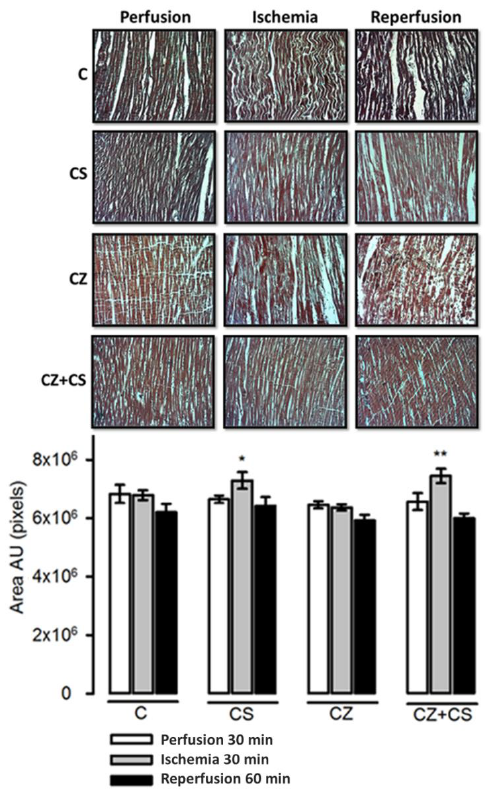
Figure 8. Representative photomicrographs of heart tissue after perfusion (30 min), ischemia (30 min) and reperfusion (60 min) from the four experimental groups. Area values are the mean ± SE ( n = 5 in each group). The tissue was processed according to conventional histological procedures, and histological sections were made and stained by Masson’s trichrome stain at 16x. Control hearts with reperfusion showed injured in the myocytes with wavy fiber, but the CS treatment restored the morphology of the tissue. However, the CZ treatment was not capable of restoring morphology and breakage of the fibers was observed. The morphology of the tissue in the CZ+CS group was very similar to that of the C group. * CS + Ischemia (I) vs. CZ + I, p = 0.03; ** CZ + I vs. CS+CZ + I, p = 0.01. Therefore, the activation of TRPV1 may protect the heart by regulating oxidative stress, the NO pathway, and by controlling the flow of Ca 2+ to prevent damage to the car-